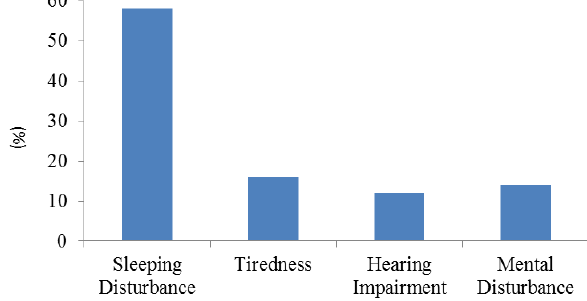
Fig. 4. Response of health effects caused by noise